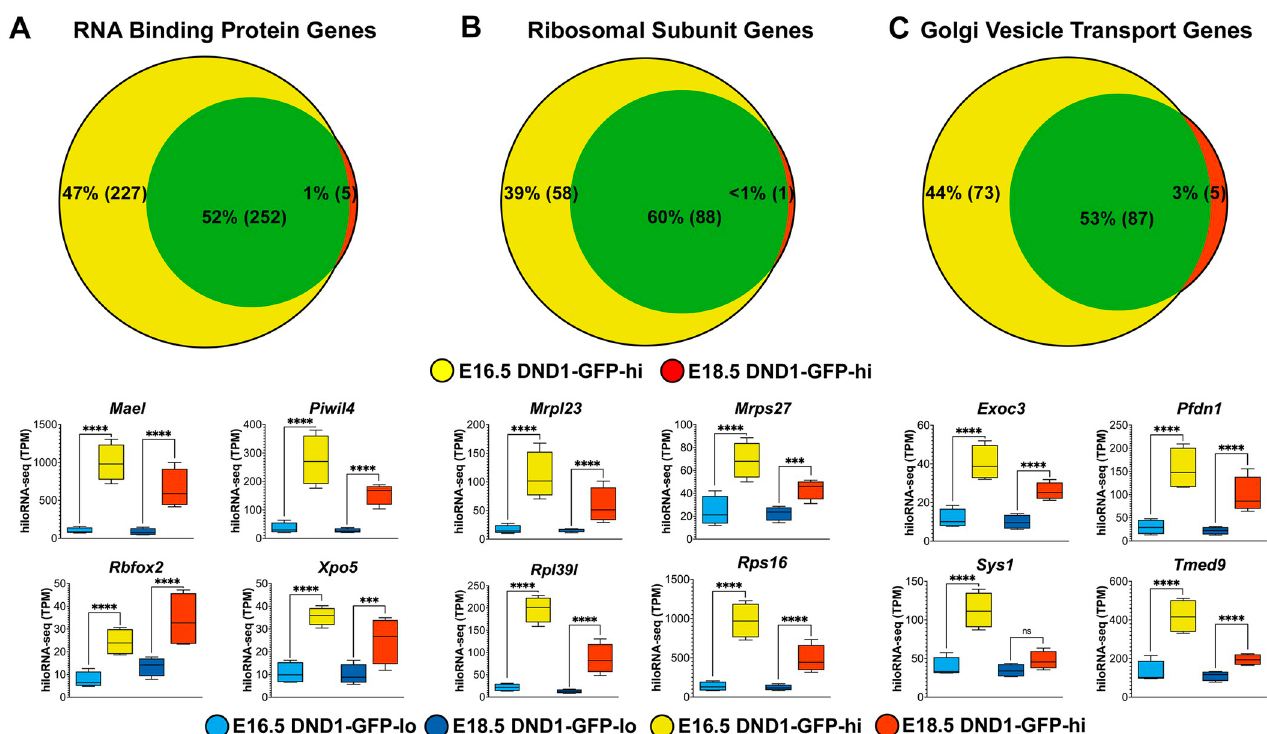
Fig 5. In DND1-GFP-hi cells, most transcripts for proteins involved in RNA binding, ribosomal subunits, and Golgi vesicle transport are either shared between E16.5 and E18.5, or unique to E16.5. Venn diagrams showing temporal distribution (E16.5 (yellow), E18.5 (red)) of genes in three GO biological processes significantly over-represented in DND1-GFP-hi cells compared to DND1-GFP-lo cells: ( A ) RNA binding protein genes, ( B ) ribosomal subunit genes, and ( C ) Golgi vesicle transport genes. Box-and-whisker plots show expression for example genes in each category. hiloRNA-seq expression P-value (DESeq2) between DND1-GFP-lo and DND1-GFP-hi cells at E16.5 and E18.5: not significant (ns), < 0.05 ( � ), < 0.01 ( �� ), < 0.001 ( ��� ), < 0.0001 ( ����